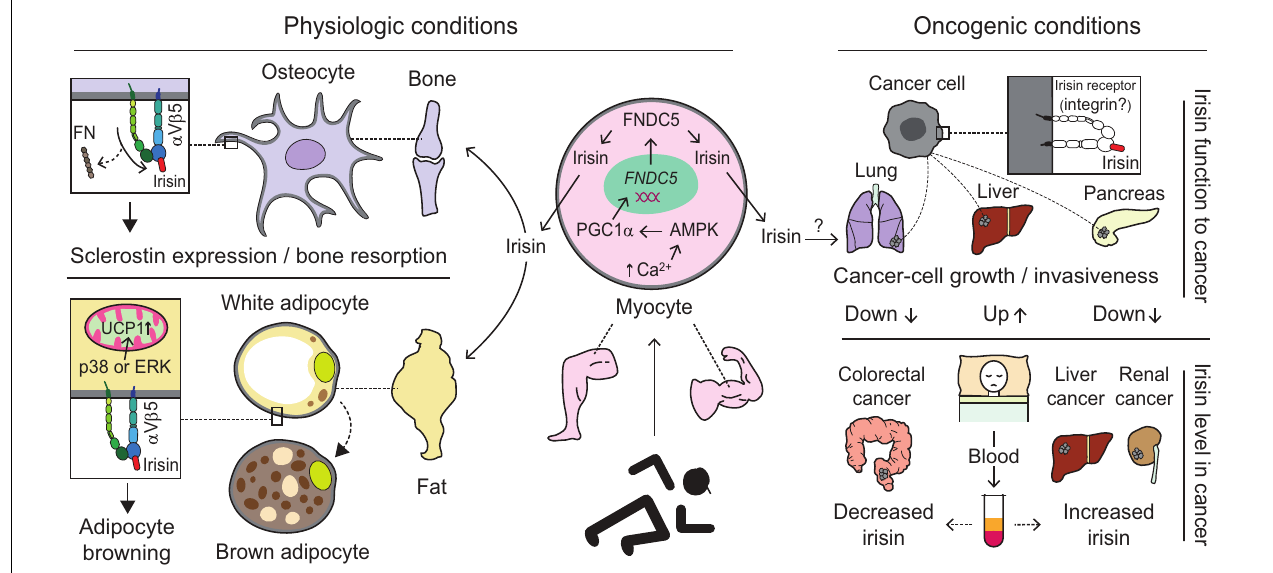
FIGURE 4 | Biological interactions mediated by integrins with irisin. Exercise-induced production and release of irisin from the myocytes of skeletal muscle through activation of the AMPK-PGC1 α -FNDC5 axis alters biological pathways via interaction with integrin (Bostrom et al., 2012; Shan et al., 2013; Gamas et al., 2015). Under physiologic conditions, irisin migrated to the bone via blood circulation preferentially, compared to FN, interacts with integrin α V β 5 acting on osteocytes to induce sclerostin expression and bone resorption. Moreover, irisin binding to V β 5 on adipocytes is believed to facilitate adipocyte browning through the activation of p38 or ERK followed by increases in UCP1 (Zhang et al., 2014; Kim et al., 2018). Under oncogenic conditions, irisin binding to cancer cells is thought to have different impacts, although irisin receptors specific to cancer cells exist remains an open question. Specifically, irisin plays a role in inhibiting the growth or invasiveness of lung- and pancreatic-cancer cells (Shao et al., 2017; Liu et al., 2018), whereas it stimulates liver-cancer cells to promote tumor progression (Shi et al., 2017). In addition, the levels of irisin in blood (serum or plasma) of cancer patients appear to vary depending on which organ is primarily cancerous. For example, increased levels of irisin were found in liver- and renal-cancer patients (Gaggini et al., 2017; Altay et al., 2018), while decreased levels were detected in colorectal-cancer patients (Zhu et al., 2018). This suggests irisin levels may serve as a diagnostic marker for different cancers. AMPK, adenosine monophosphate (AMP)-activated protein kinase; PGC1 α , peroxisome proliferator-activated receptor coactivator 1 α ; FNDC5, fibronectin type III domain-containing protein 5; FN, fibronectin; ERK, extracellular signal-regulated kinase; and UCP1, uncoupling protein